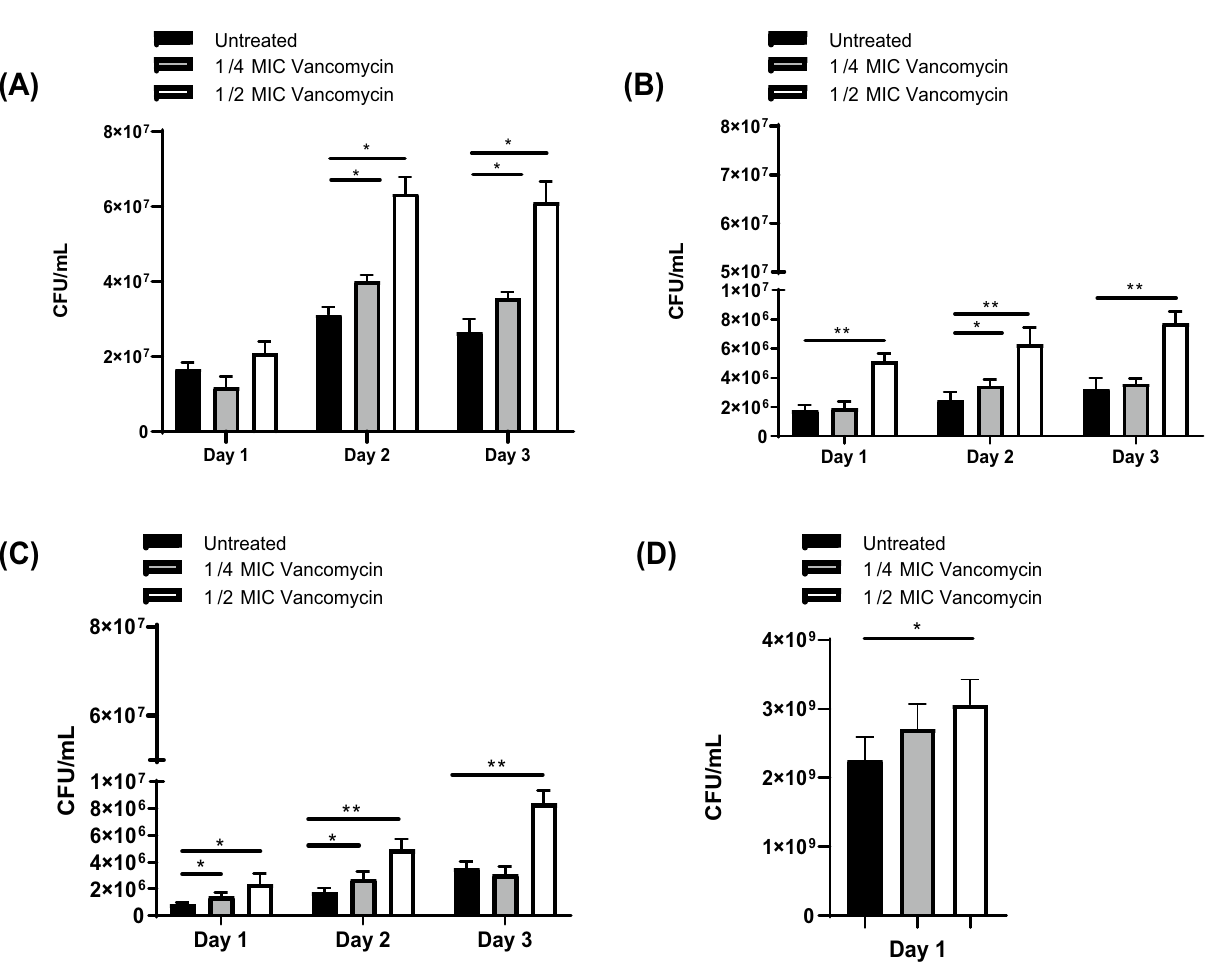
Figure 3. Sub-MIC vancomycin promotes S. aureus biofilm growth in ( A ) MRSA JE2, ( B ) MSS A Newman and ( C ) SH1000, ( D ) Sub-MIC vancomycin promotes MRSA JE2 S. aureus biofilm growth on fibrinogen coated wells. N = 4 per treatment group. Error bars represent standard deviation. *p < 0.05, **p <